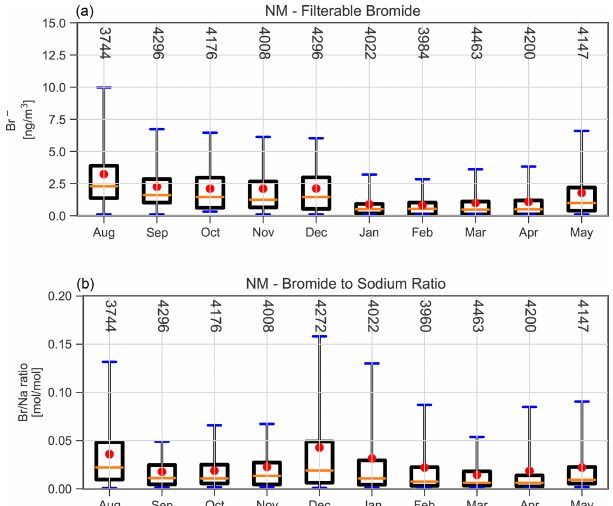
Figure 8. Box and whisker plots of the seasonal variation in the par- ticulate bromide concentration (a) and bromide to sodium ratio (b) determined from aerosol filter